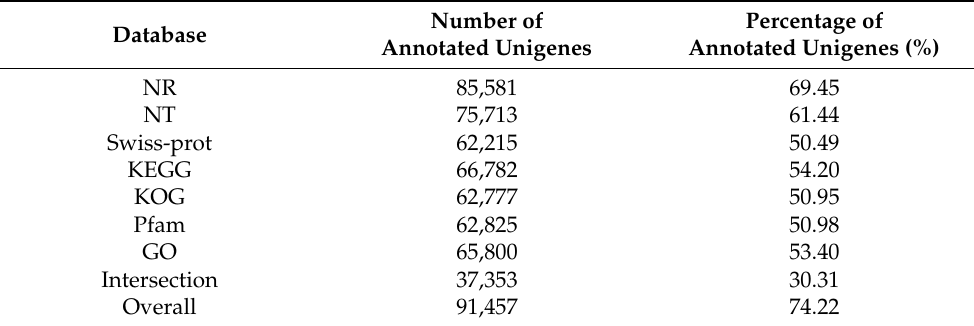
Table 1. Summary of annotations for the assembled Avena sativa unigenes in public